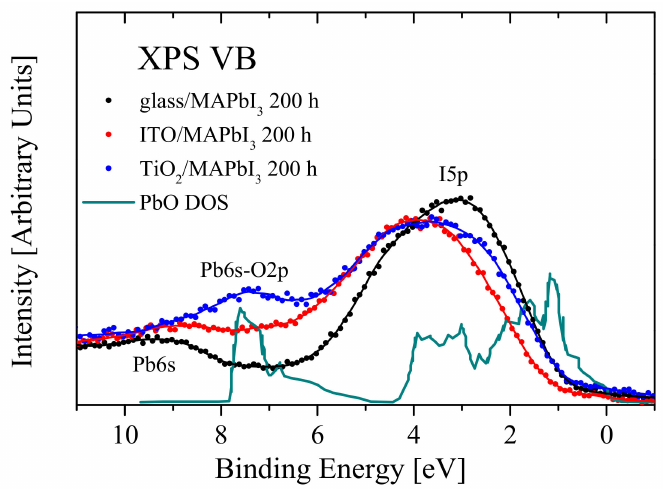
Figure 9. XPS VB spectra of light-soaked MAPbI 3 hybrid perovskites prepared on different substrates as